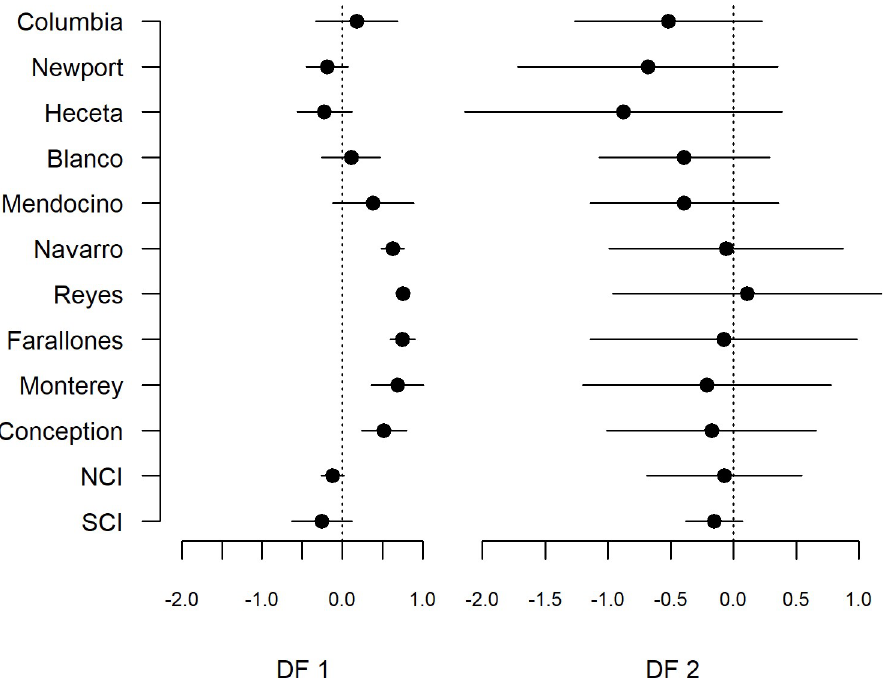
Fig 7. Loadings plot on regions from the dynamic factor analysis; regions are ordered north to south. Error bars are 95% confidence intervals. NCI and SCI are northern and southern Channel Islands, respectively. Note, the loading for SCI trend 2 has no error estimate because it was set to zero (pre-rotation) as a necessary requirement of constraining the DFA model.